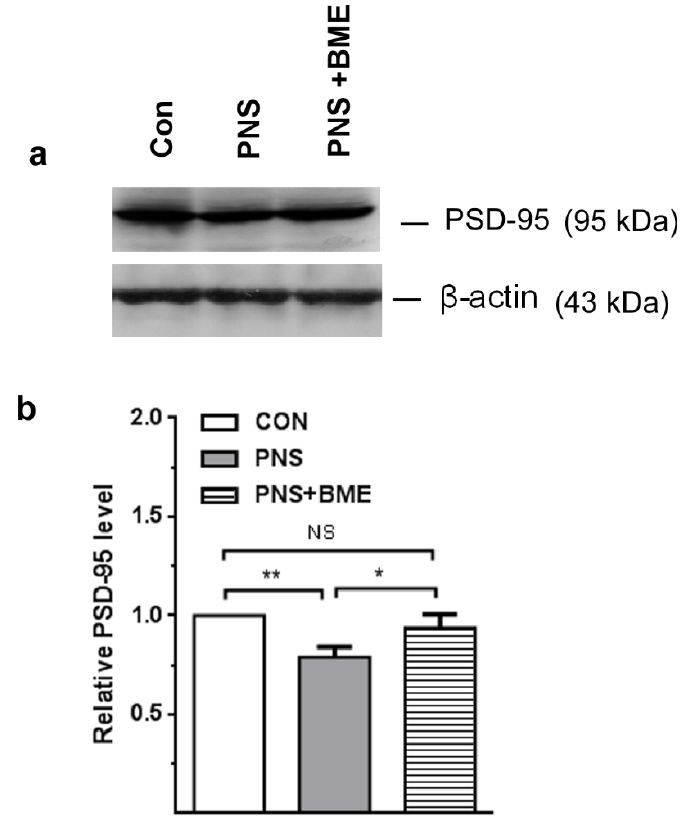
Figure 11. Effect of exposure to BME treatment on postsynaptic density protein 95 (PSD-95) in PNS offspring. ( a ) Representative Western blot depicting the level of PSD-95 in the experimental groups; ( b ) Exposure to BME treatment significantly increased the expression of PSD-95. Data are expressed as mean ± SEM ( n = 6/each group). One-way ANOVA followed by Bonferroni post hoc test (for all pairwise multiple comparisons statistical significance is indicated by * p < 0.05 and ** p < 0.01; NS—Not significant).